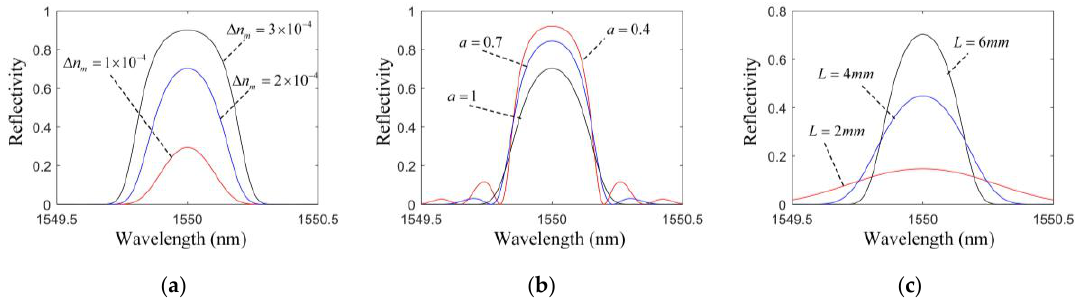
Figure 7. Reflected spectrum of FBGs with different parameters: ( a ) L = 6 mm , a = 1; ( b ) L = 6 mm